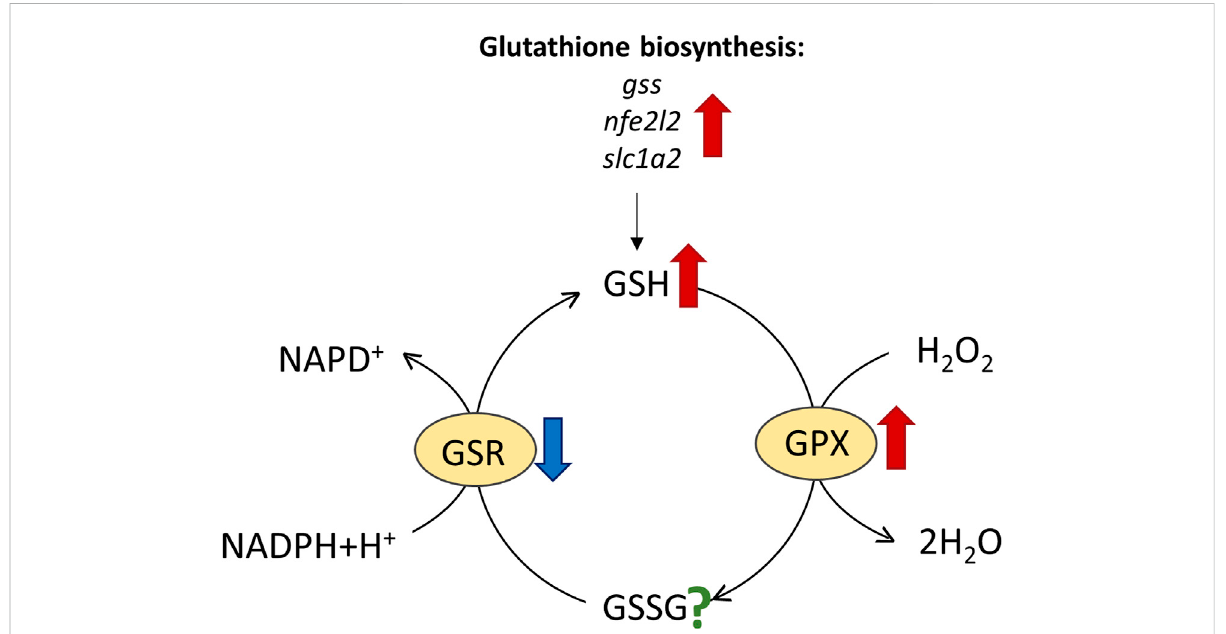
harpand/orhoodedsealsvs.miceareindicatedbyredarrowsandreducedactivitybybluearrows,whilethequestionmarksigni fi esunknownactivity